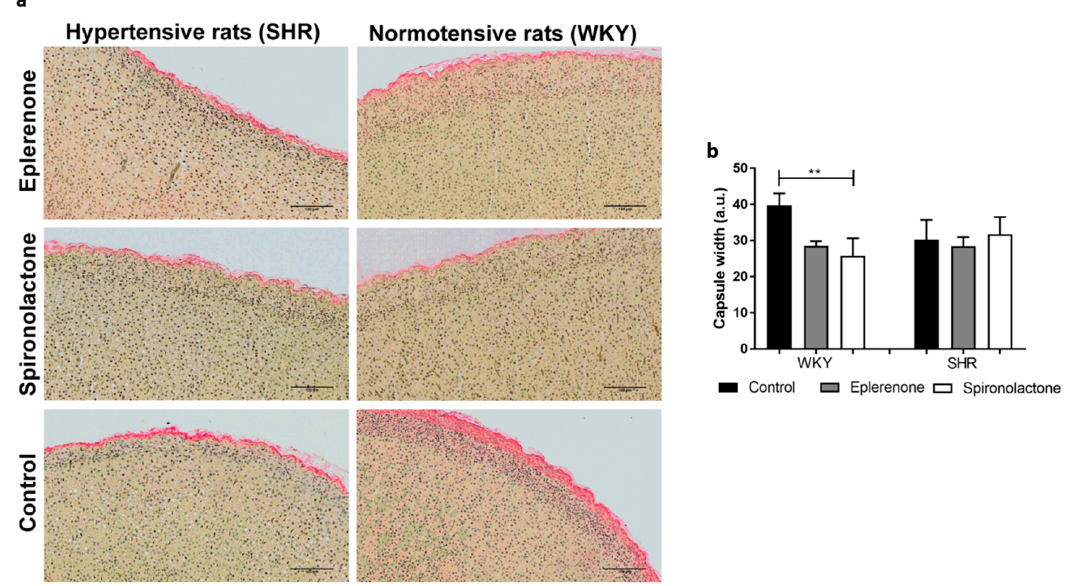
Figure 3. Adrenal glands stained with Sirius red (100×) ( a ) and adrenal capsule width comparison between all the analyzed groups ( b ). ** p < 0.01.